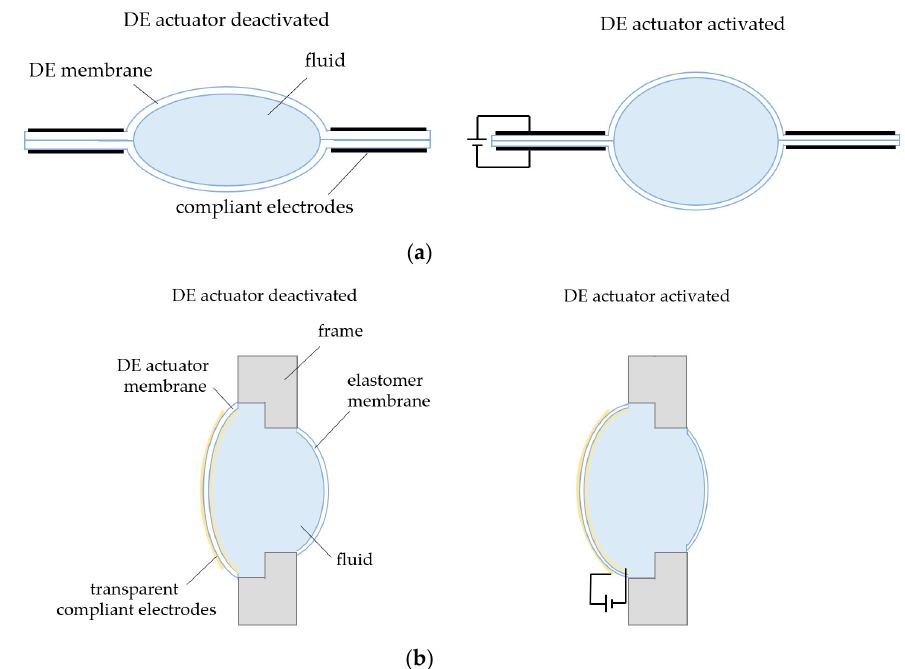
Figure 13. An operation principle of two fluid-filled elastomeric lenses using DEAs: ( a ) bioinspired lens; ( b ) transparent DEA lens.